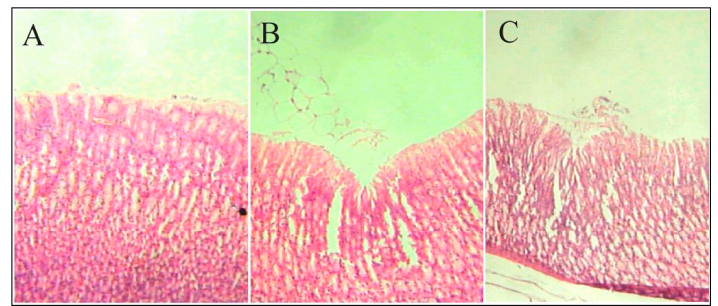
Figure 5. Binocular light microscope images of stomach histopathology of control rats ( A ), rats treated with pristine ketoprofen ( B ) and rats treated with ketoprofen contained in pH-sensitive polyspheres ( C ). Reprinted with permission from [60]. Copyright© 2019 Elsevier.